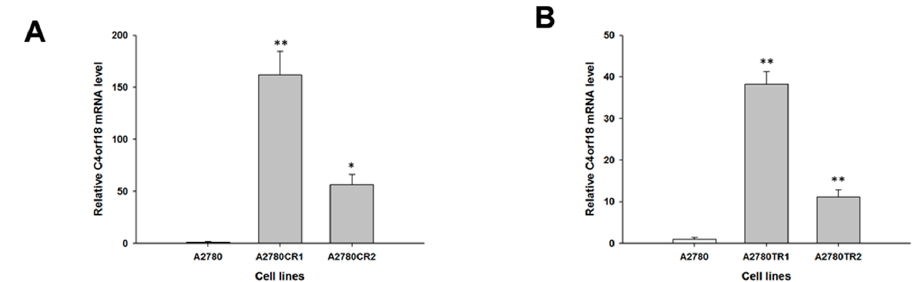
Figure 3. Expression analysis (Q-PCR) of the C4orf18 gene in: A2780 CIS-resistant cell lines ( A ); and A2780 TOP-resistant cell lines ( B ). The figure presents relative the gene expression in resistant cell lines (grey bars) with respect to the sensitive cell line (white bars), assigned as 1. The values were considered significant at * p < 0.05 and ** p < 0.01.